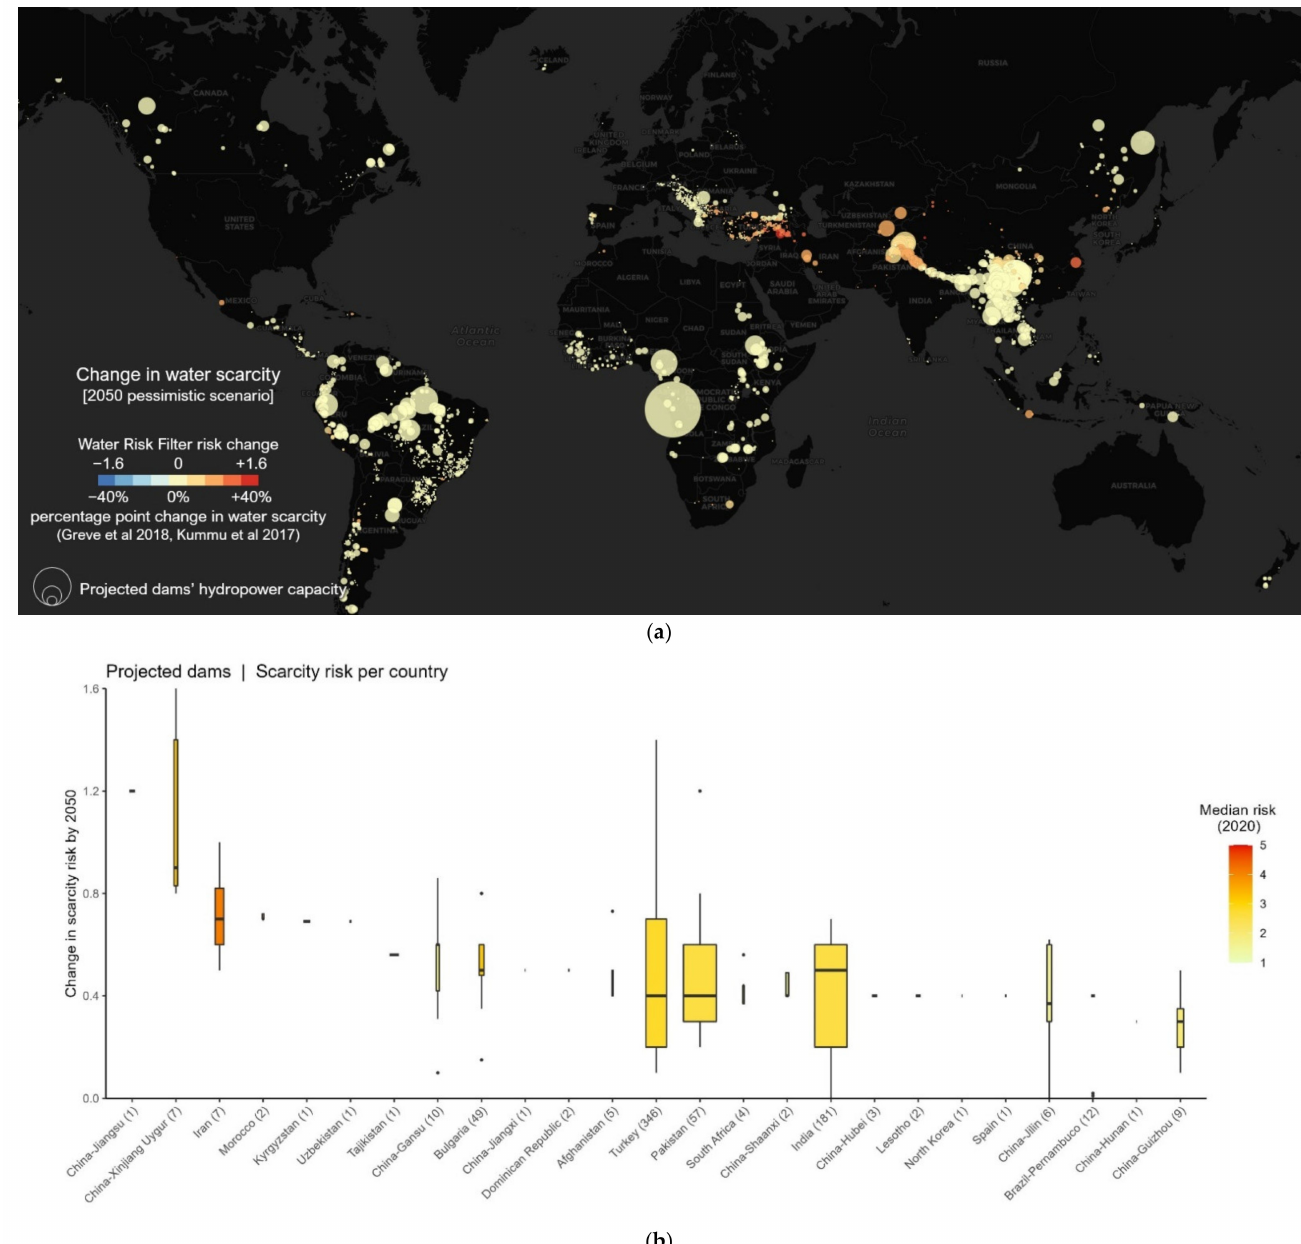
Figure 8. ( a ) Distribution of projected hydropower dams with color indicating the projected change in relative risk for water scarcity in 2050 under the pessimistic scenario. The size of the circle reflects the hydropower capacity of the dam. See the interactive version of this map at https: //rcamargo.shinyapps.io/HydropowerClimateChange; (accessed 21 January 2022). ( b ) Change in water scarcity risk (vertical axis) for the basins of projected hydropower dams by 2050 according to country or subnational region under the pessimistic scenario. Bar color indicates current risk and width indicates aggregate hydropower